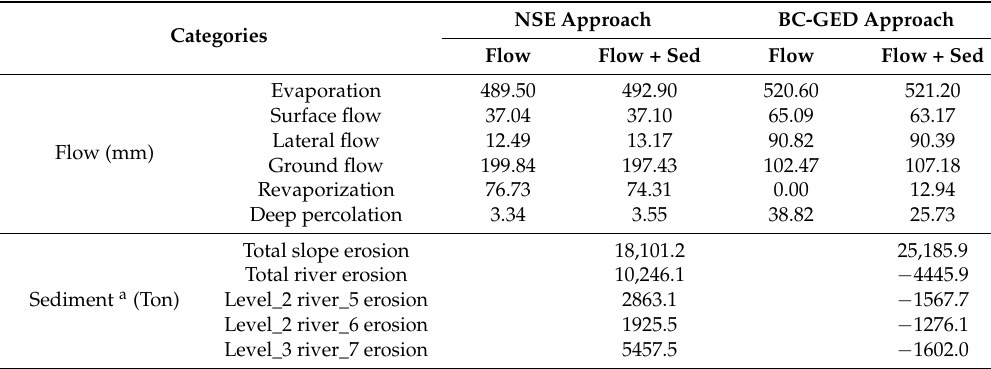
Table 4. The average annual component of simulated flow and sediment.